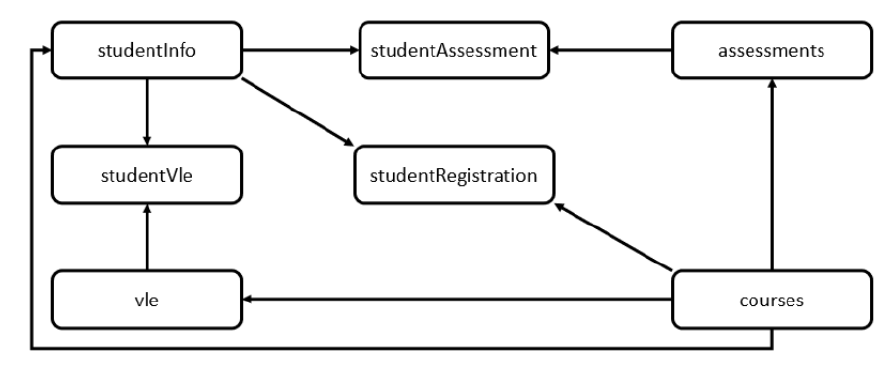
Figure 3 Information in Data